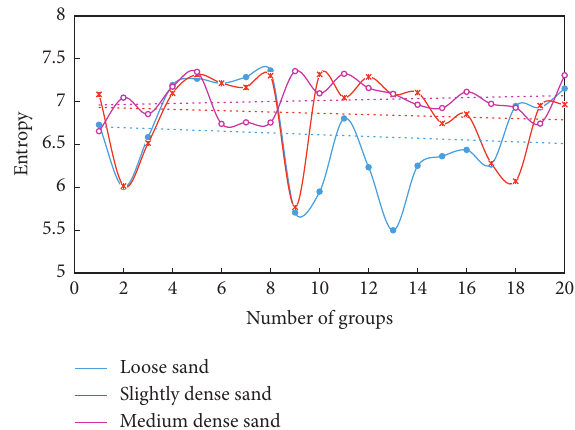
Figure 10: Variation of two-dimensional entropy of sand with different compactness.